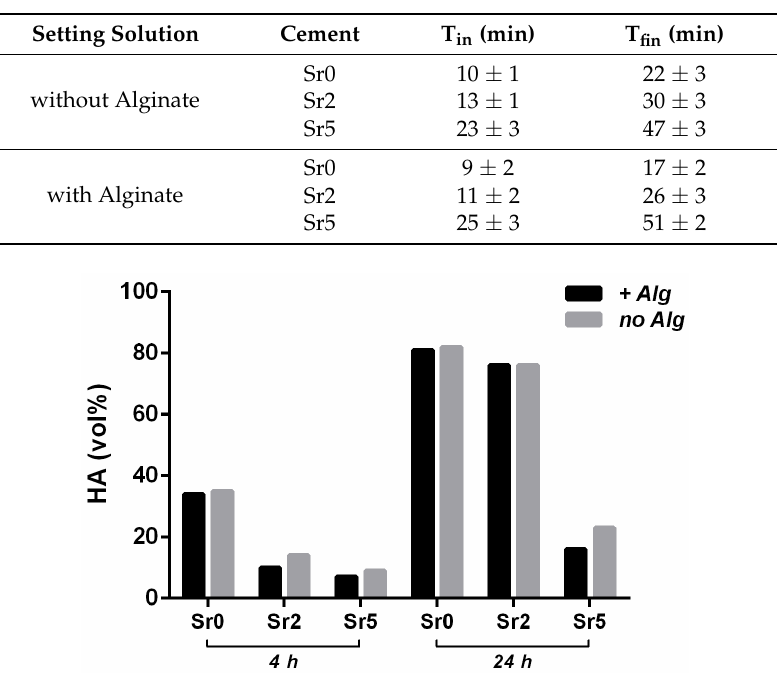
Table 3. Setting times of Sr-substituted formulations.